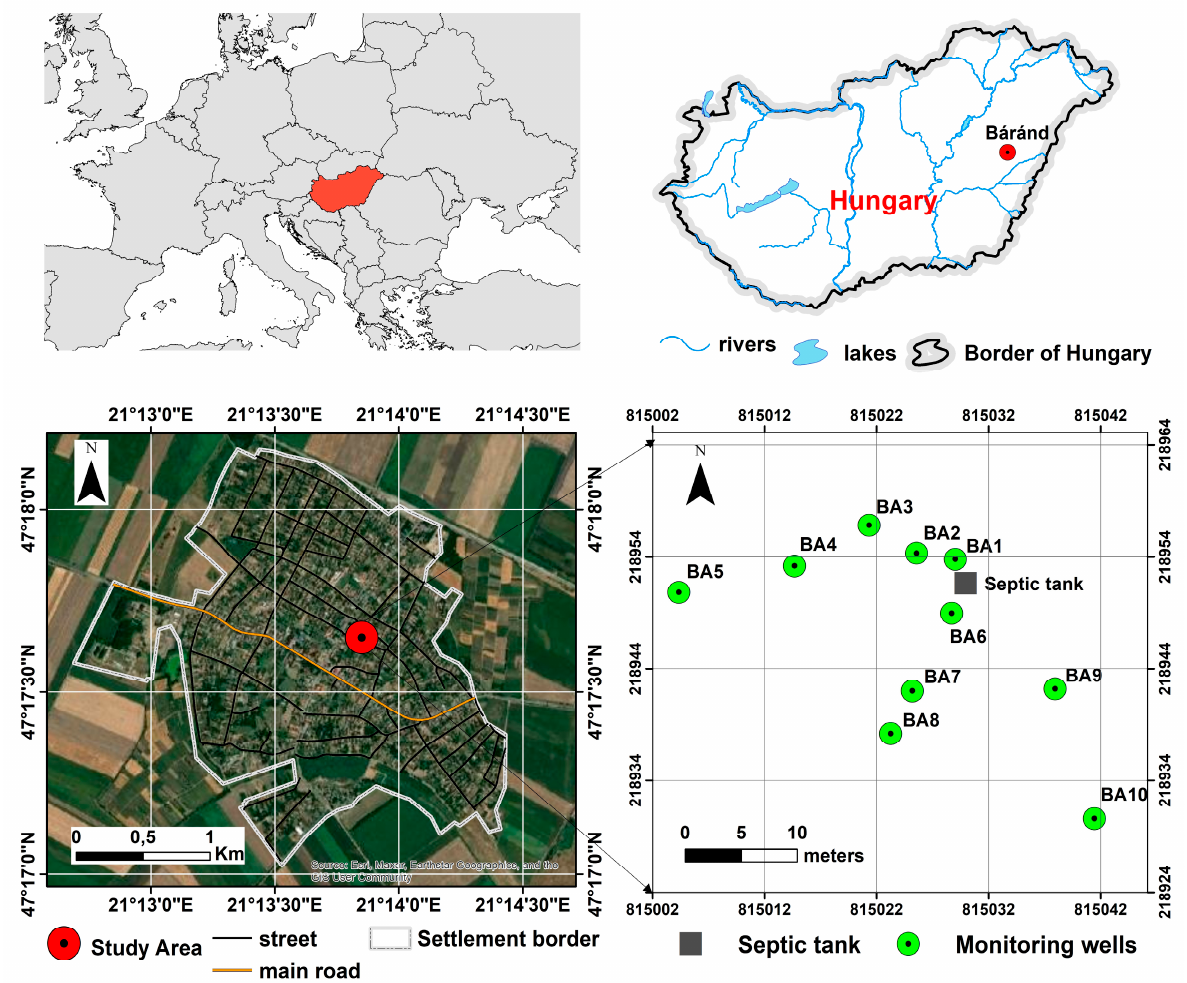
Figure 1. Location of the uninsulated septic tank and the monitoring wells. Soil formation is influenced by groundwater near the surface, which has resulted in predominantly Vertisol, Solonetz, Chernozem and Kastanozem soil types, according to the World Reference Base for Soil Resources (WRB) classification system [30]. Saline soils are predominant in 36% of the micro region, while 16% of the area is covered by meadow Chernozem soils which are not directly affected by groundwater. Based on the soil analyses from the 3 m deep boreholes in the sample area, the soil texture is dominated by fine particle fractions (<0.02 mm), with a combined proportion of clay and silt